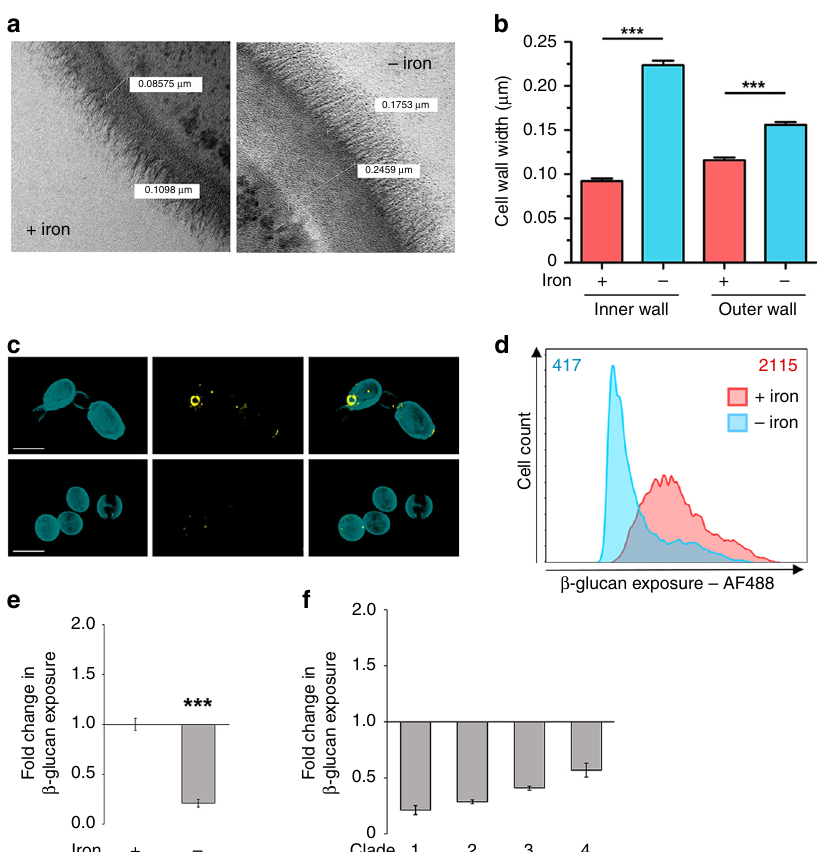
Fig. 4 Iron limitation triggers cell wall remodelling and β -glucan masking. a Wild type C. albicans cells (SC5314: Supplementary Table 1) were grown under iron replete ( + iron control) and iron-limiting conditions ( − iron), and their cell walls examined by transmission electron microscopy. The thickness of the inner and outer layers of these cell walls was quanti fi ed using Image-J. b Means and standard deviations from images of cells ( n = 50) from three independent replicate experiments are shown. The data were analysed using ANOVA with Tukey ’ s multiple comparison test: *** p < 0.001. c Three- dimensional images acquired using Airyscan microscopy. Yeast were grown in the presence of iron (upper panels) or the absence of iron (lower panels), and then cell wall chitin and exposed β -glucan were stained with calco fl uor white (cyan) and Fc-Dectin1 (yellow), respectively: scale bars, 5 μ m. d Analysis of β -glucan exposure on C. albicans SC5314 cells grown under iron replete (pink) or iron-limiting conditions (cyan) by Fc-dectin-1 staining and fl ow cytometry. The fi gure shows one representative pro fi le for three independent experiments, and the median fl uorescence intensity (MFI) for each population is indicated. e The fold change in β -glucan exposure for C. albicans SC5314 cells grown under iron-limiting conditions was calculated relative to control iron replete cells. f Quanti fi cation of iron-limitation-induced β -glucan masking in C. albicans clinical isolates: clade 1, SC5314; clade 2, IHEM16614; clade 3, J990102; clade 4, AM2005/0377 (Supplementary Table 1). Means and standard deviations from three independent replicate experiments are shown, and the data were analysed using ANOVA with Tukey ’ s multiple comparison test: **** p < 0.0001. Source data are provided as a Source Data fi